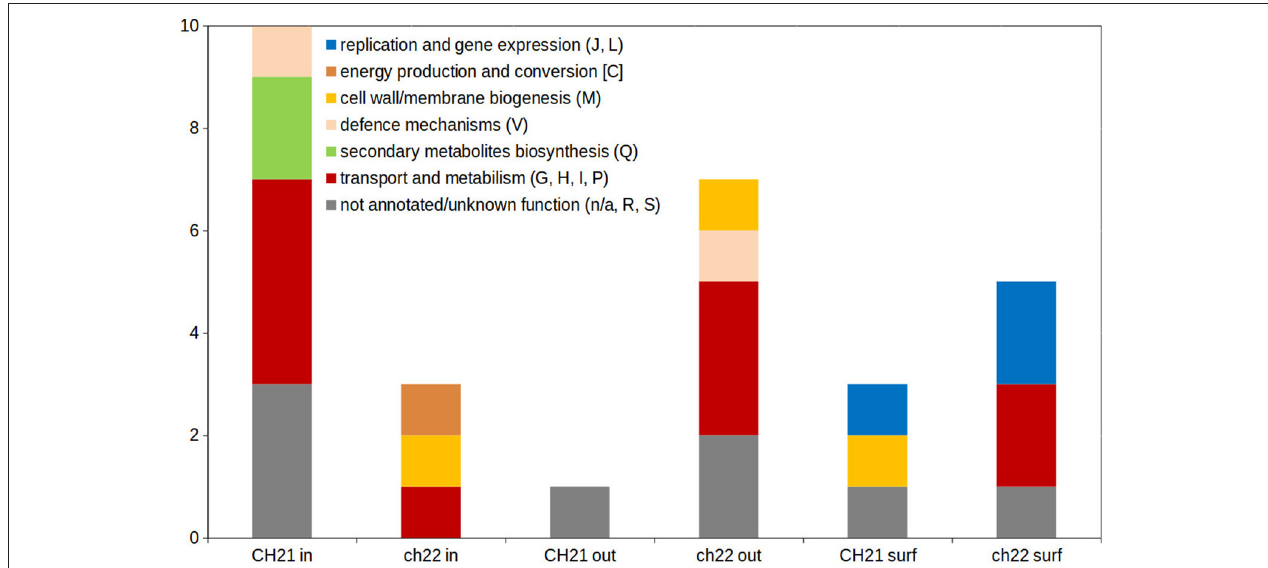
FIGURE 7 | Distribution of functional categories of Clusters of Orthologous Groups (COGs) within differentiating proteins identified during analysis of intracellular (in), extracellular (out) and cell membrane/wall-associated (surf) proteome. One letter code of functional categories corresponds to the code in COGs database [https:// www.ncbi.nlm.nih.gov/COG/; ( Galperin et al.,